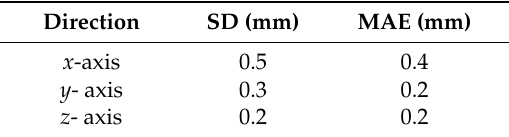
Figure 4. ( a–c )Time history of the background noise in the composite instrument measurements in experimental Case 1. The prism was set up on a stable site, 60 m away from the composite instrument. Table 2. Standard deviations (SD) and mean absolute errors (MAE) of background noise in the composite instrument measurements .